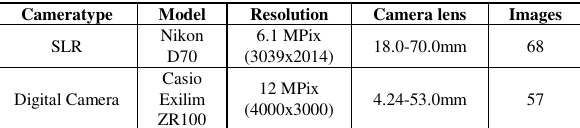
Table 1. Camera specification and viewpoint setup